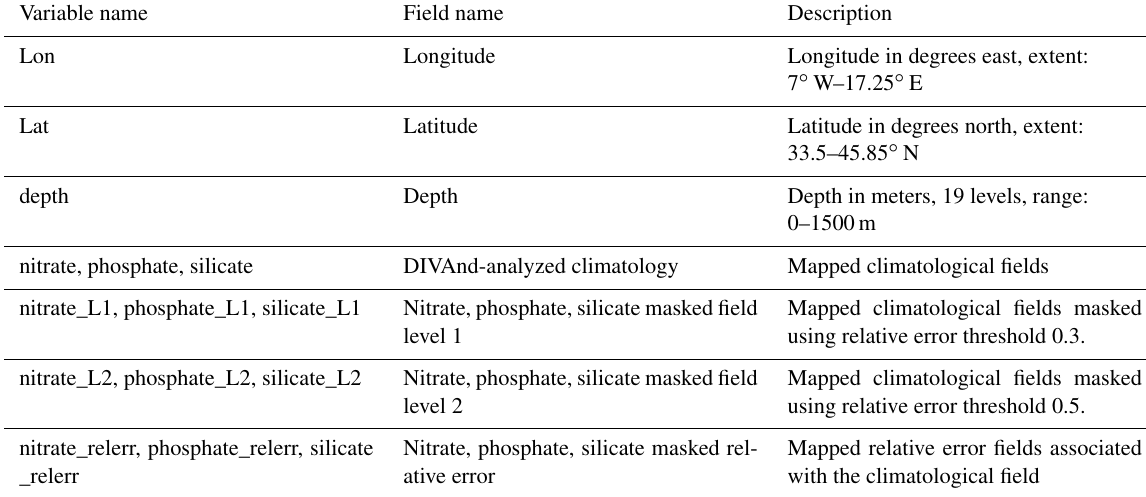
Table 3. Available analyzed fields and related information in the netCDF